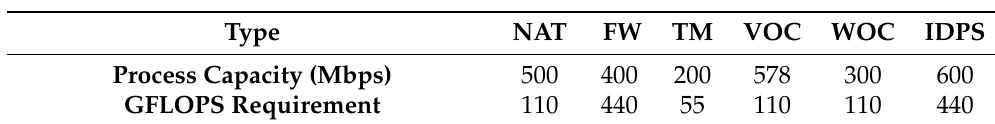
Table 3. VNF details